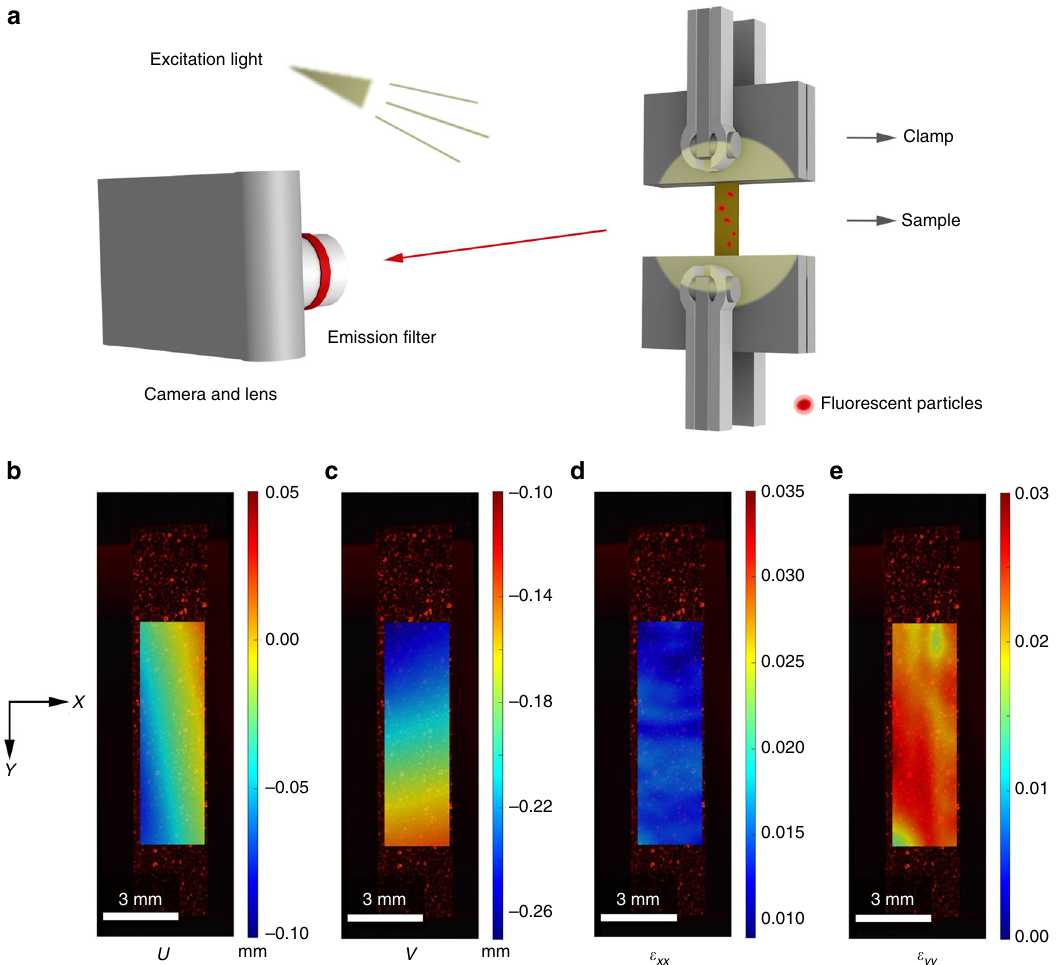
Fig. 1 Tensile tests of chemically modi fi ed graphene fi lms monitored by fl uorescent digital image correlation. a Schematic diagram of the fl uorescent digital image correlation (FDIC) measurement, where camera and lens detect light emitted from red fl uorescent particles deposited onto the e -GO 0 fi lms (prepared by evaporation of GO solution synthesized at 0 °C). The emission fi lter allows only light from the excited fl uorescent particles to pass. b – e Optical images of e -GO 0 fi lms with fl uorescent particles on its surface, and the displacement fi elds U ( b ) and V ( c ), and the strain fi elds measured in the transverse ( d ) and longitudinal ( e ) directions from FDIC analysis. Source data are provided as a Source Data fi average Poisson ’ s ratios for the fi lms are determined as − 0.26